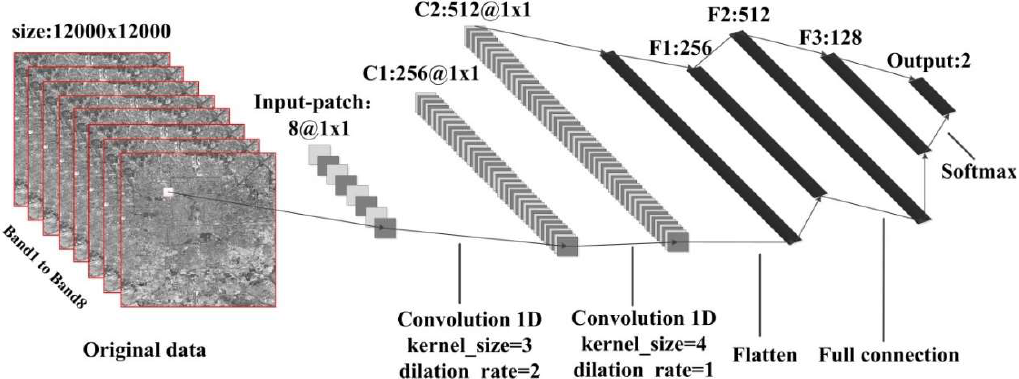
Figure 5. Network structure of CNN_1D.